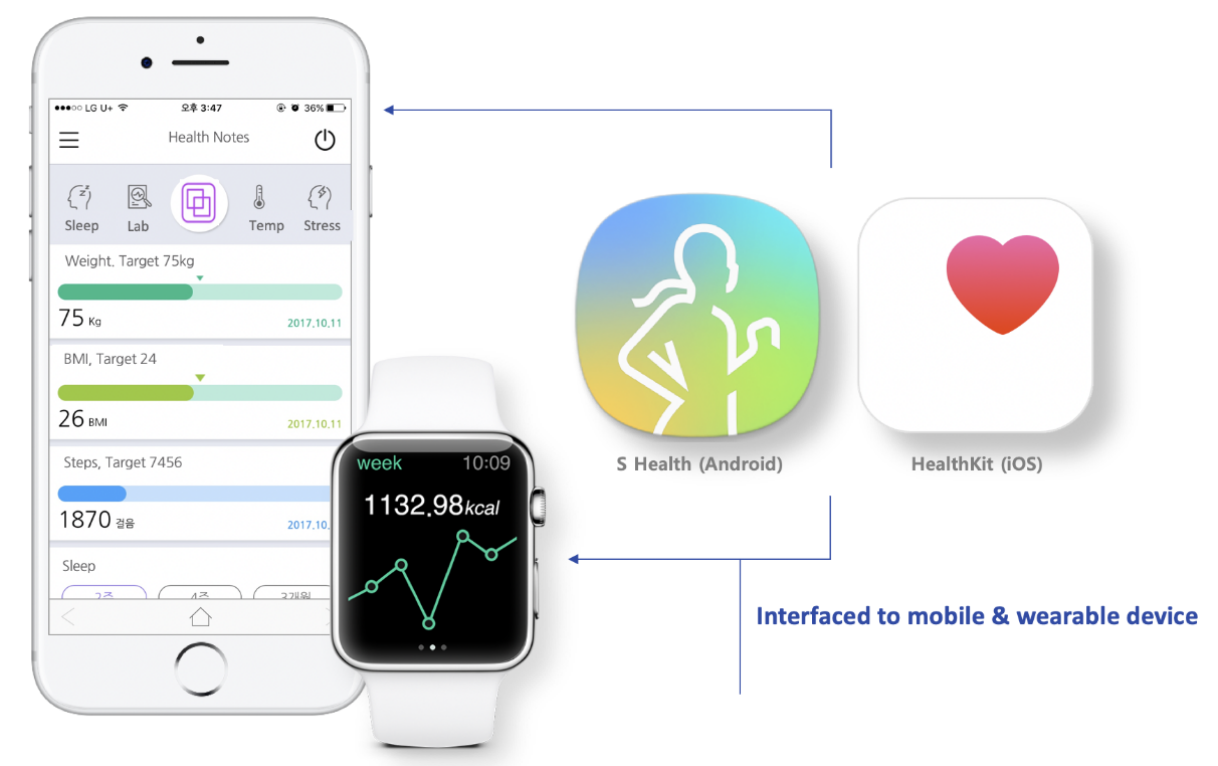
Figure 4. Direct integration of mobile and wearable data.